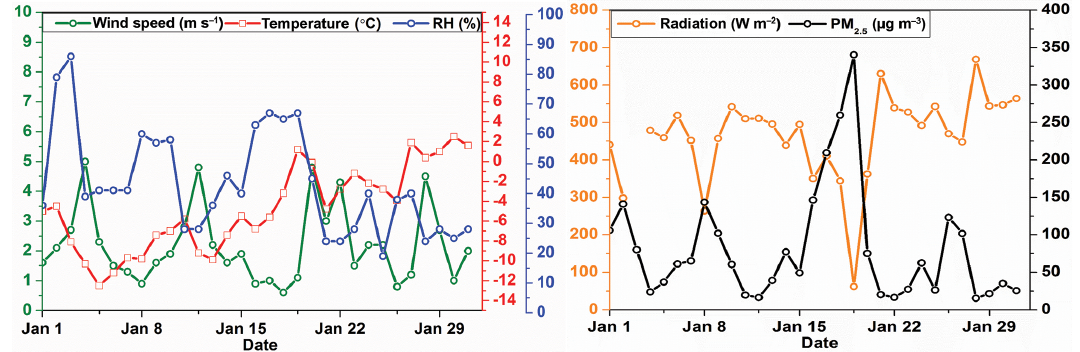
Figure 3. Observed near-surface daily meteorological variables and PM 2 . 5 concentrations in Beijing for January 2010.